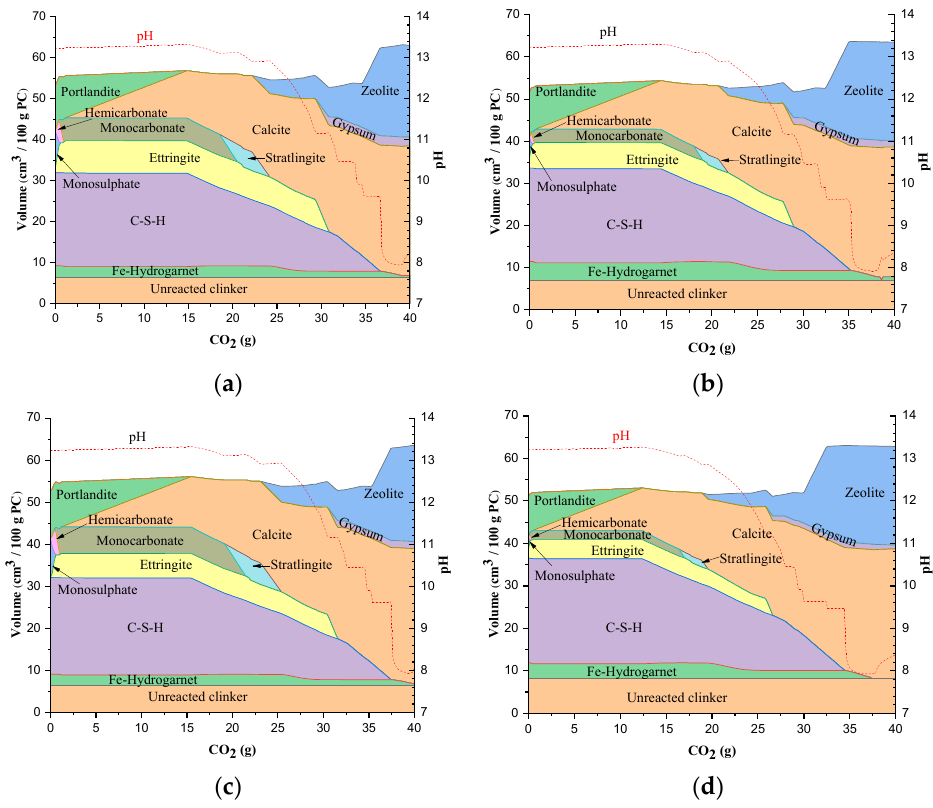
Figure 1. Simulation of carbonation of Portland cement: ( a ) type I, ( b ) type II, ( c ) type III and ( d ) type IV.